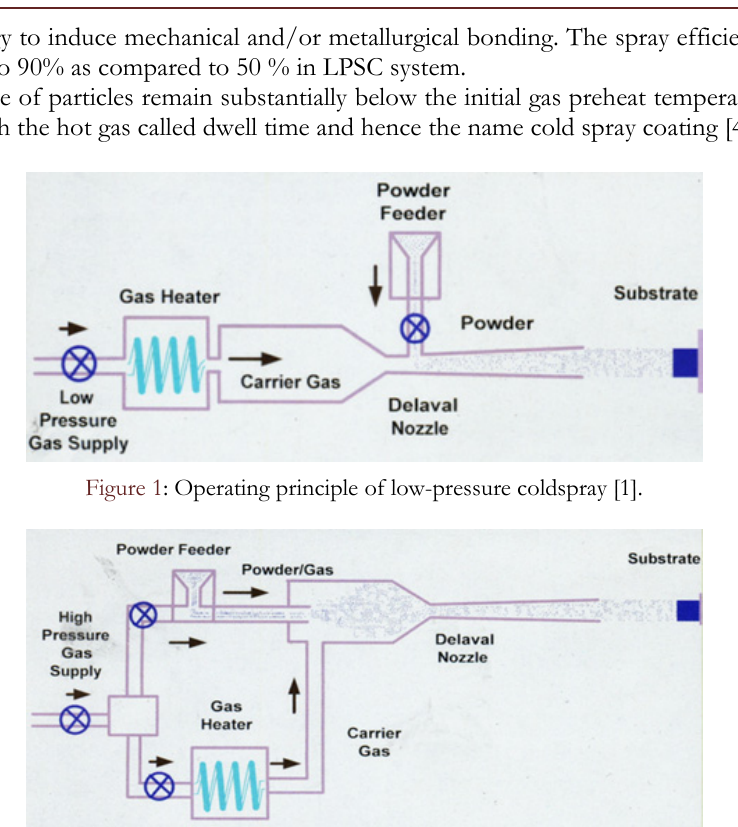
Figure 2: Operating principle of high-pressure coldspray